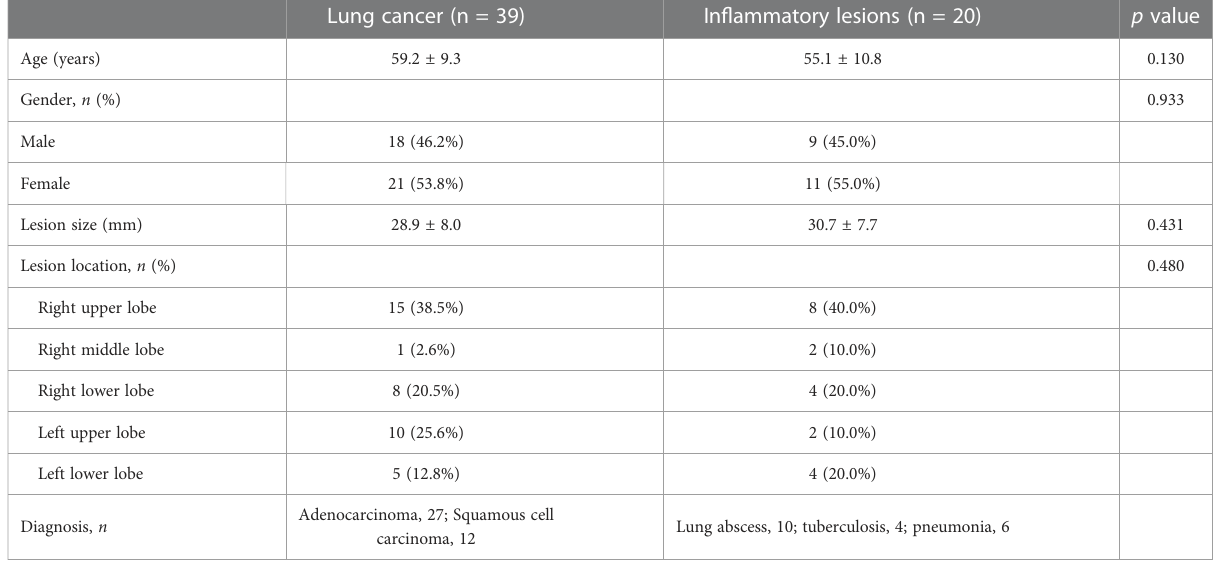
TABLE 2 Demographic and clinical characteristics of the two patient